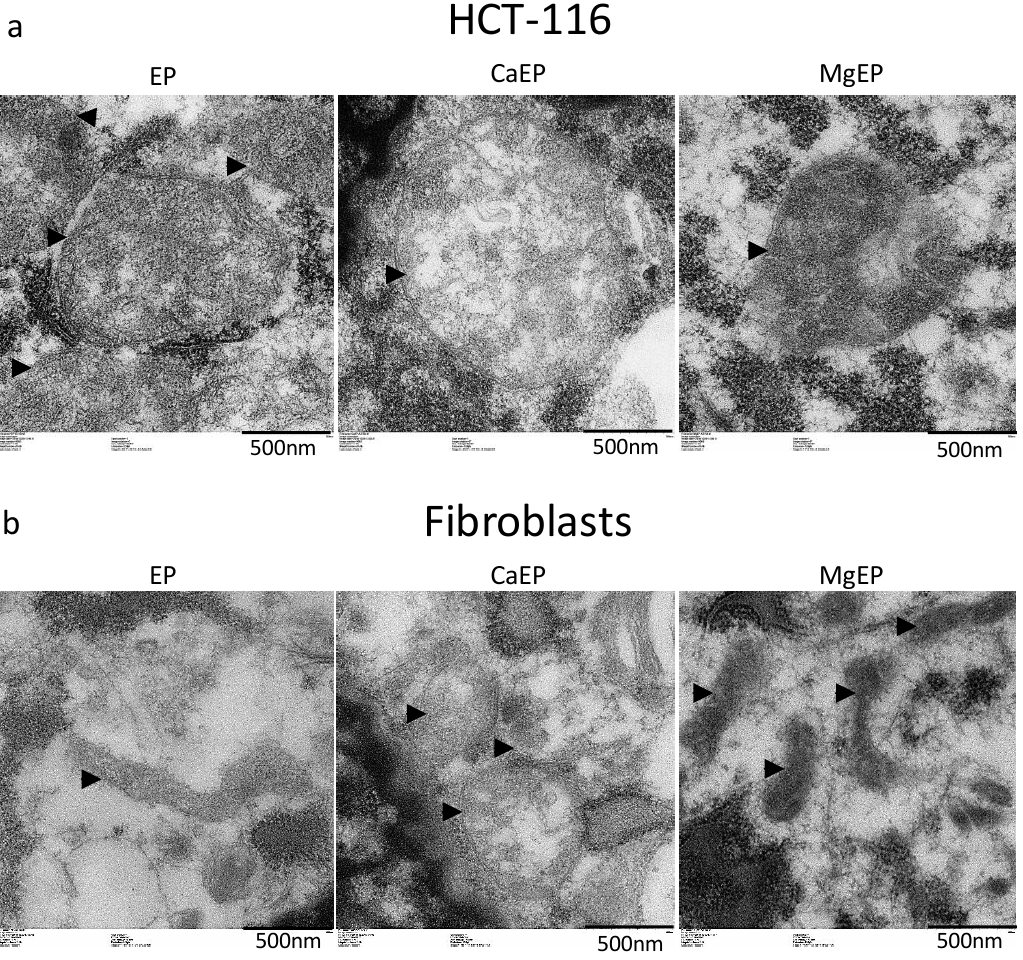
Figure 5. Ultrastructural aspect of mitochondria 5 min post-treatment observed by transmission electron microscopy. ( a ) HCT-116 tumor cells. ( b ) Normal dermal fibroblasts. Arrow heads indicate external membrane of mitochondria. Pictures are representative of what was observed in the cell population.